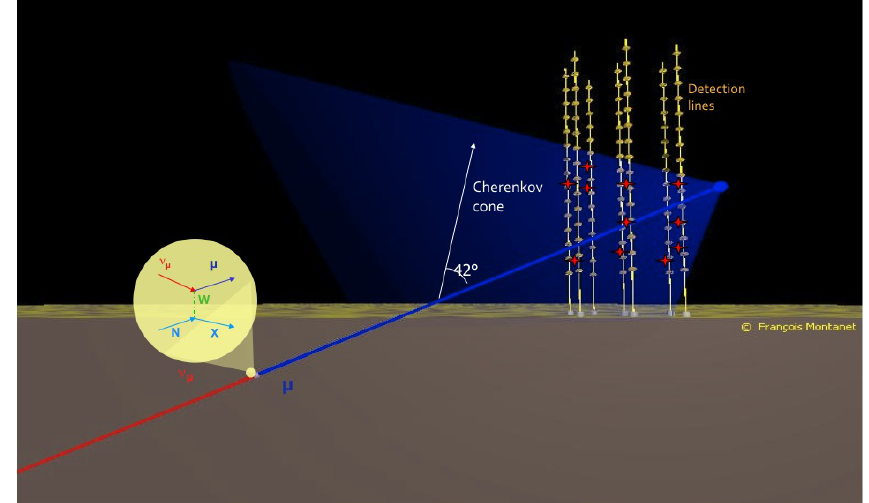
Fig. 3. Detection principle of neutrino-induced charged particles with an underwater telescope.